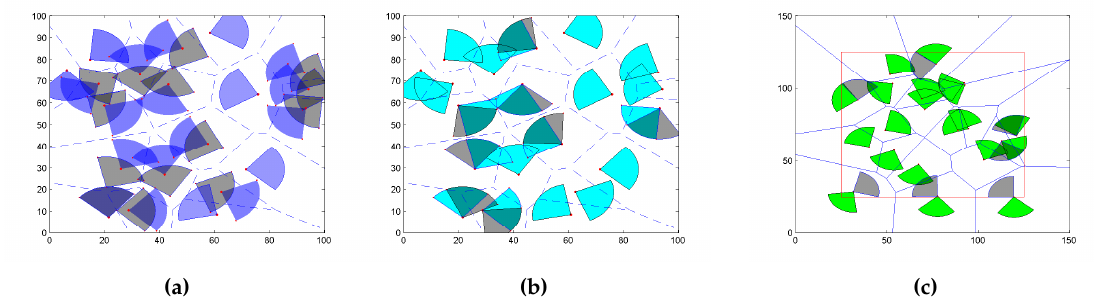
Figure 2. Example of mobility and rotation. ( a ) Move Inside Cell Algorithm (MIC); ( b ) Rotate Working Direction Algorithm (RWD); ( c ) Rotation based on boundary (RB).